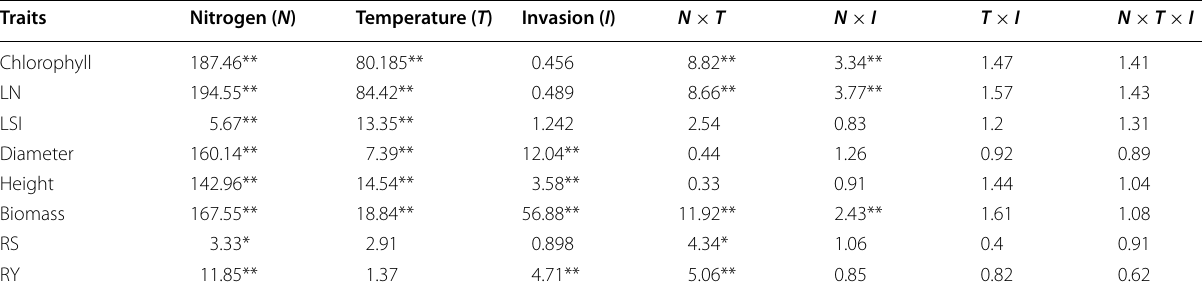
* and ** indicate p < 0.05 and p < 0.01, respectively. LSI, LN, RS and RY indicate leaf shape index, leaf nitrogen, root/shoot ratio and relative yield, respectively